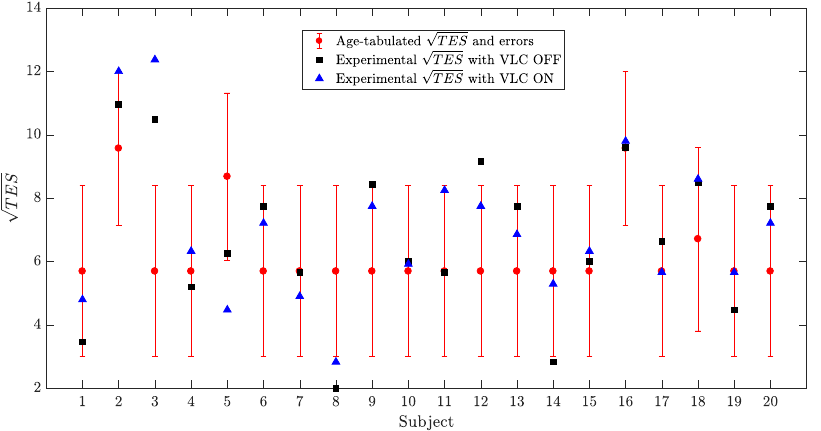
Figure 11. Representation of square roots of the total error score values for each subject. In red, ? TES and their statistical error based on the age range of the patient are the average values of ? TES measured with VLC OFF is reported; and in blue, the reported [27]; in blackm the measured with VLC ON is